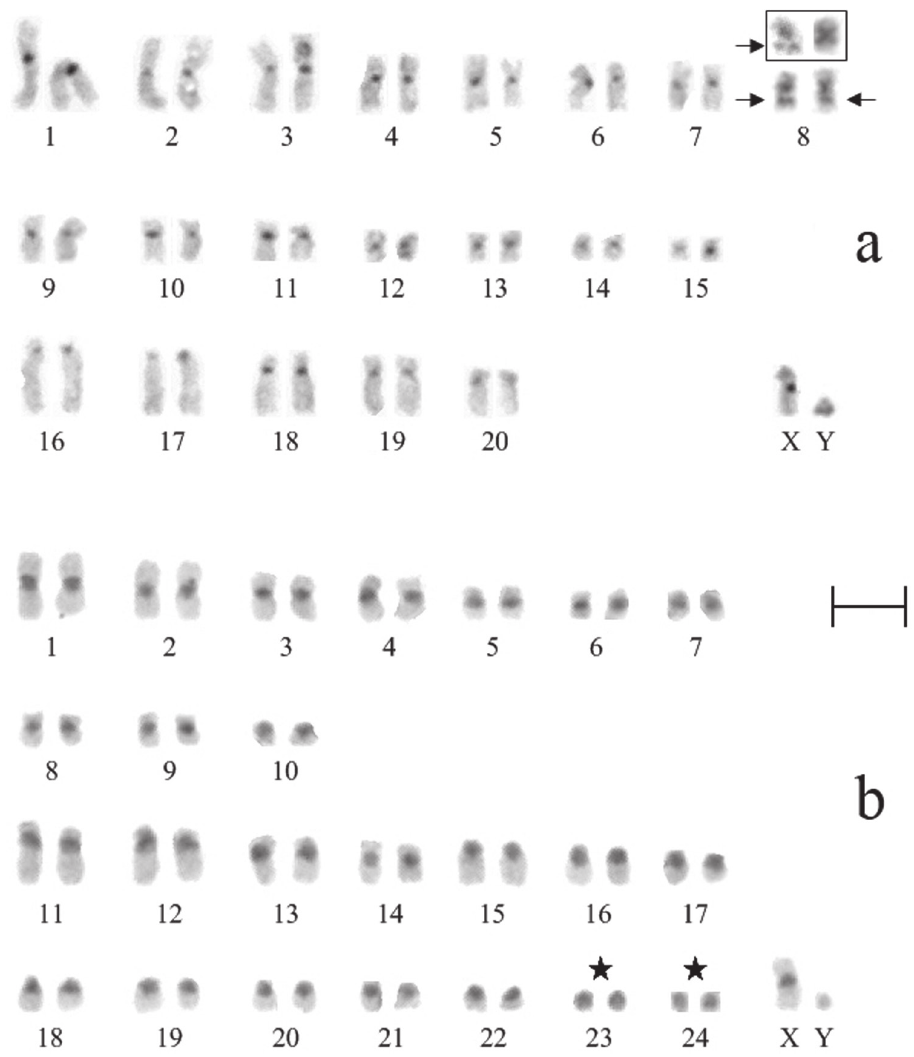
Figure 3. C-banded karyotypes of Ochotona huangensis ( a ) and O. dauurica ( b ):  – intercalary hetero- chromatic blocks,  – autosomes entirely consisted of heterochromatin. Bar = 5 The C-banding patterns of O. dauurica specimens from Transbaikalia (near the station Armagotuy) and Mongolia (Selenge aimag, near Shamar) (Ivanitskaya 1991) differs slightly from the specimen studied by us. Four pairs of subtelo-acrocentric auto- somes have euchromatic material on the short arms in our pika. According to the data obtained by Ivanitskaya (1991), euchromatic material was on the short arms only on one pair. This pair is the largest and it corresponds to our 11-th pair. In addition, Ivan- itskaya (1991) described three completely heterochromatic pairs, but according to our data, only last two pairs of autosomes have such features. These differences may be due